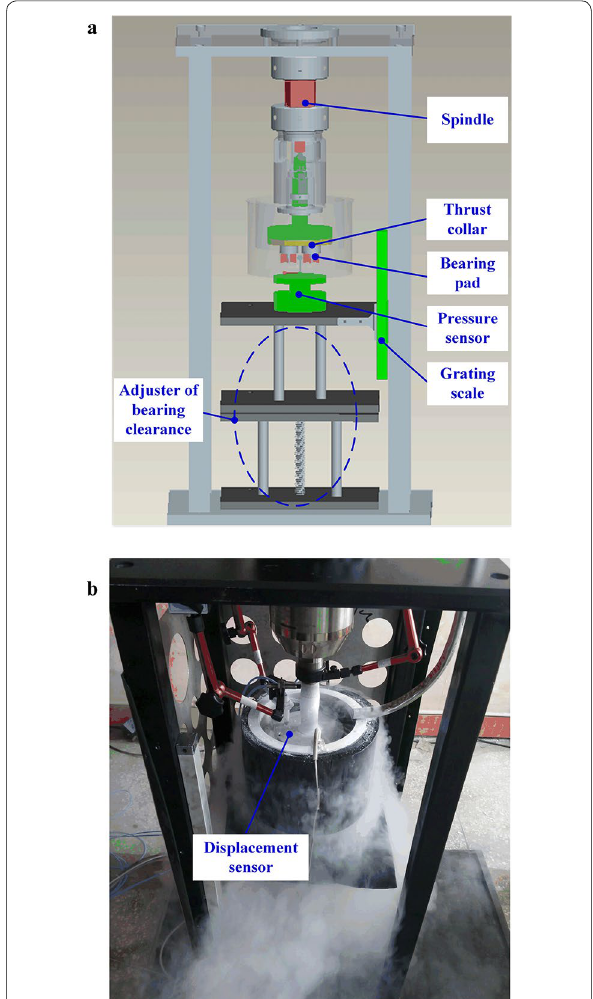
Figure 16 a Structural diagram of a high-speed experimental device for superconducting compound bearings. b Photograph of the experiment